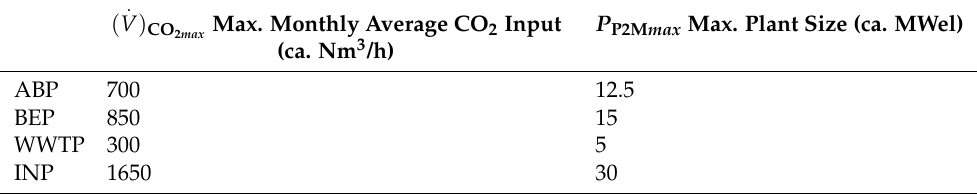
Table 4. Largest possible P2M plants by site type based on empirical data collection (with rounding because of